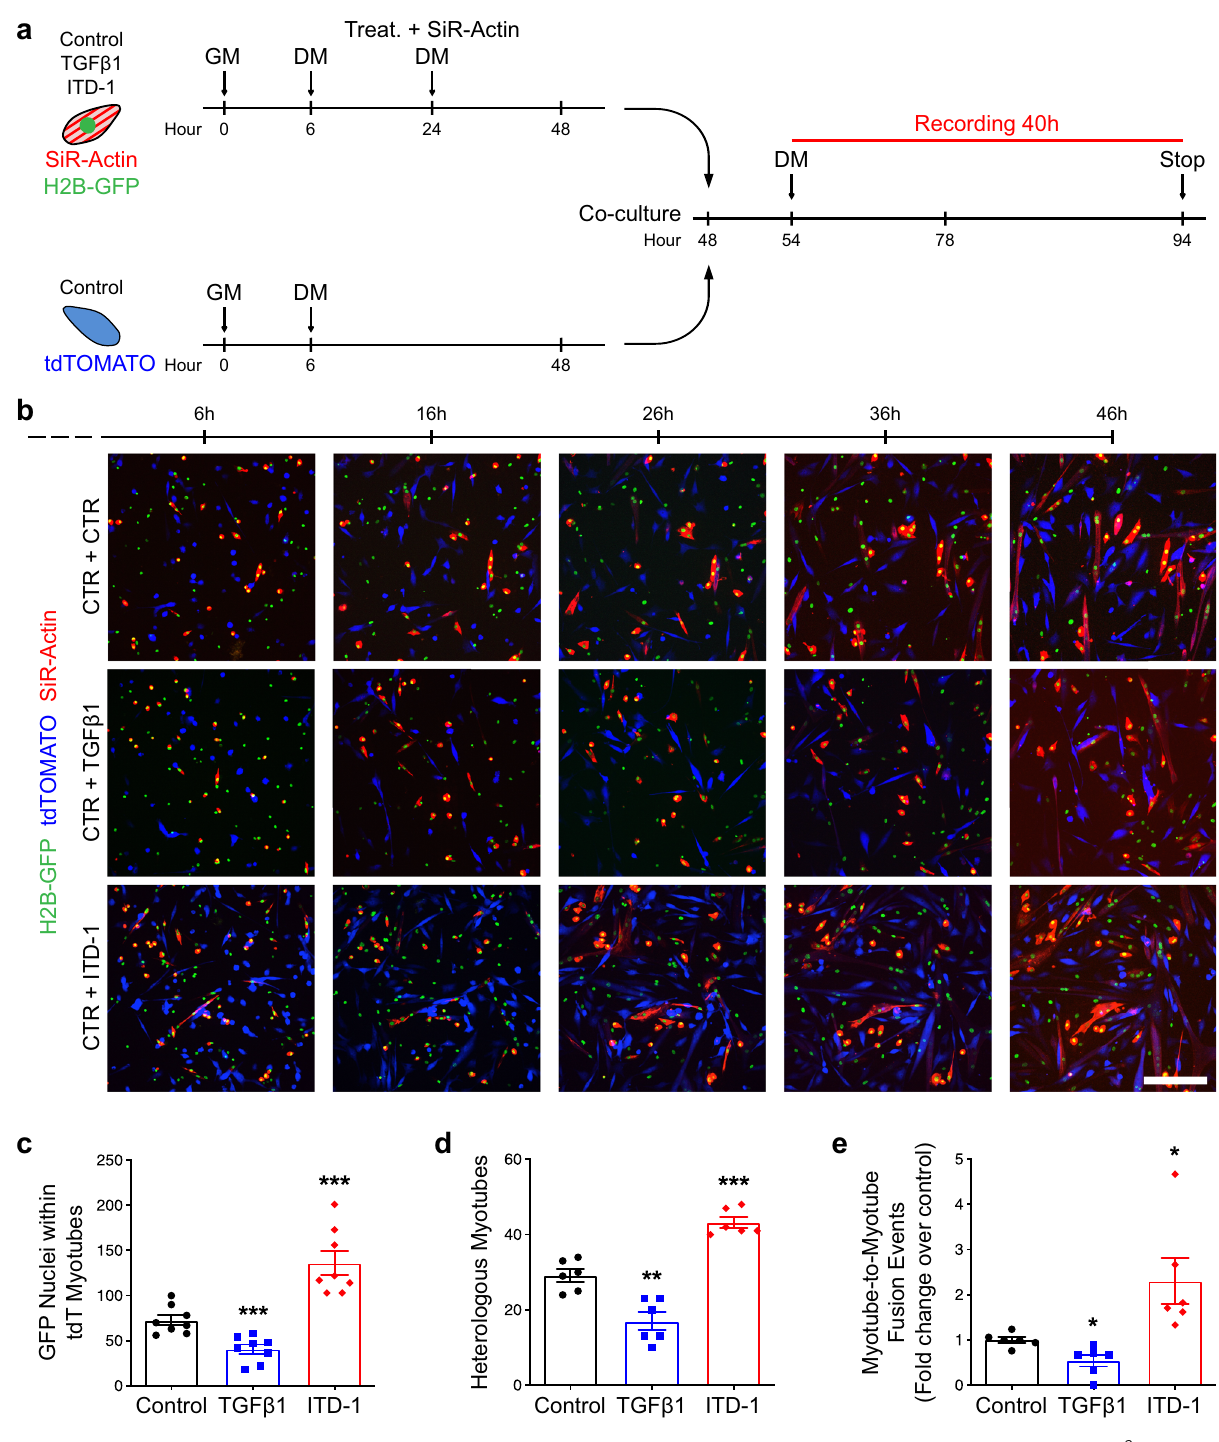
Fig. 6 Live imaging of myoblast fusion. a Experimental scheme. H2B-GFP primary myoblasts were seeded at low density (5000 cells/cm 2 ), treated with TGF β 1 protein or ITD-1 compound, stained with SiR-Actin, and differentiated for 2 days. Membrane-tdTOMATO primary myoblasts seeded at low density (5000 cells/cm 2 ) and were differentiated for 2 days. Both populations were split and co-cultured (50/50) at high density (75,000 cells/cm 2 ) for 2 more days. In the last 40 h, cells were recorded live by confocal microscopy. b Live-imaging frames of co-cultured pre-differentiated myocytes con fi rm the phenotype previously observed. TGF β activation inhibits fusion, while ITD-1 enhance fusion. N = 8 biologically independent primary co-cultures. c Quanti fi cation of H2B-GFP nuclei within tdTOMATO myotubes. N = 8 biologically independent experiments. d Quanti fi cation of heterologous myotubes (double positive for SiR-Actin and tdTOMATO). N = 6 biologically independent experiments. e Quanti fi cation of Myotube-to-Myotube events. ITD-1 treatment allows more myotube-to-myotube events compared to the control. N = 6 biologically independent experiments. Scale bars: b 200 μ m. Data are presented as mean ± SEM. Unpaired two-tailed Student ’ s t tests were used to compare between data. *, **, and *** denote a signi fi cant difference with the Control group of P < 0.05, P < 0.01, and P < 0.001 respectively. Source data are provided as a Source Data fi